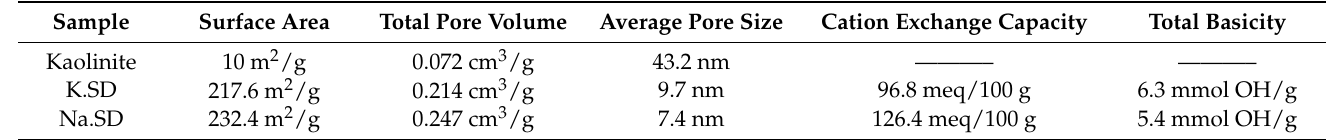
Table 1. The textural properties of kaolinite, K.SD, and